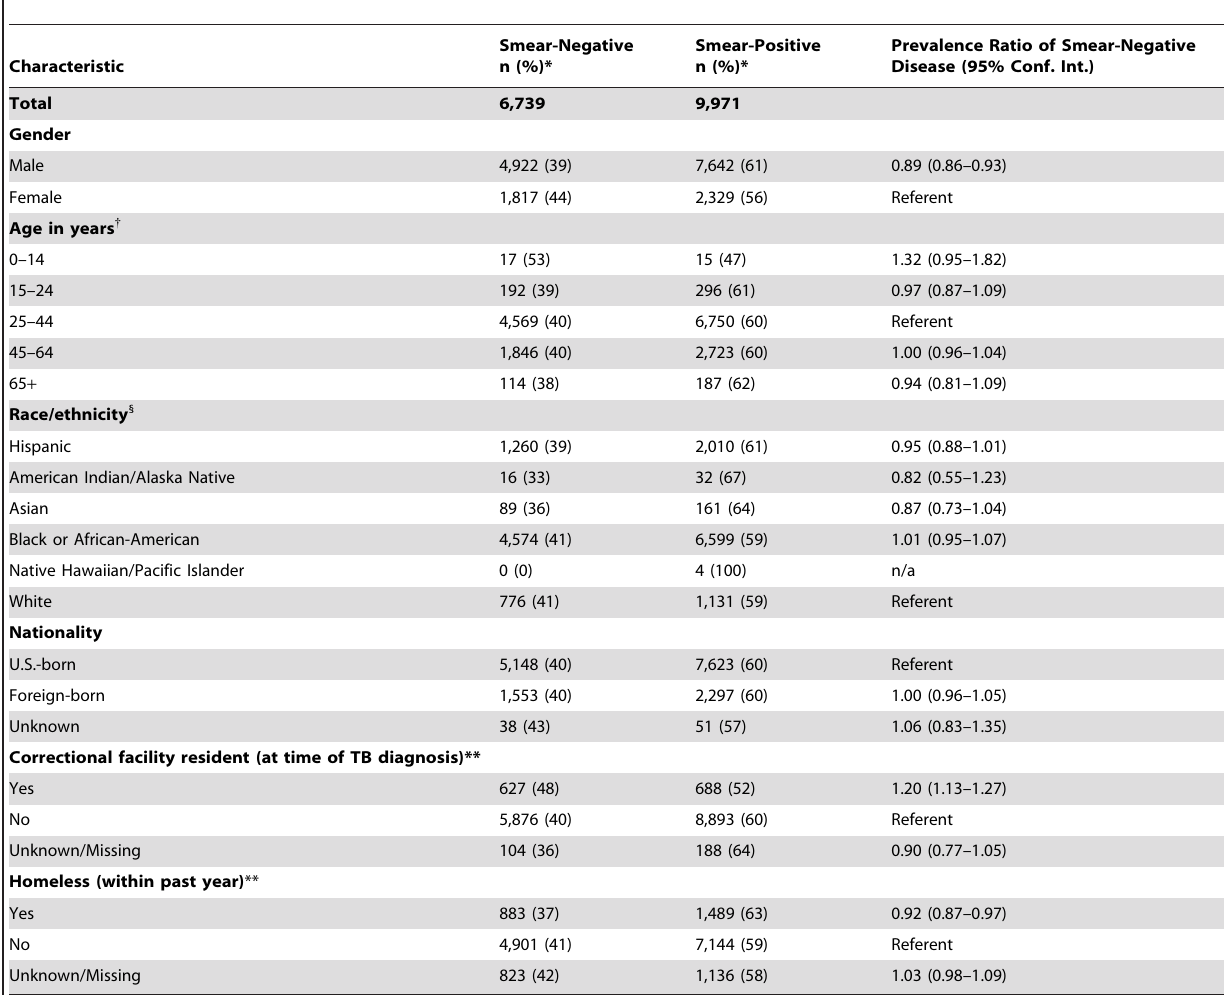
Table 1. Demographic Characteristics of Patients with HIV and Culture-Confirmed, Pulmonary TB, by Sputum AFB Smear Result, United States,